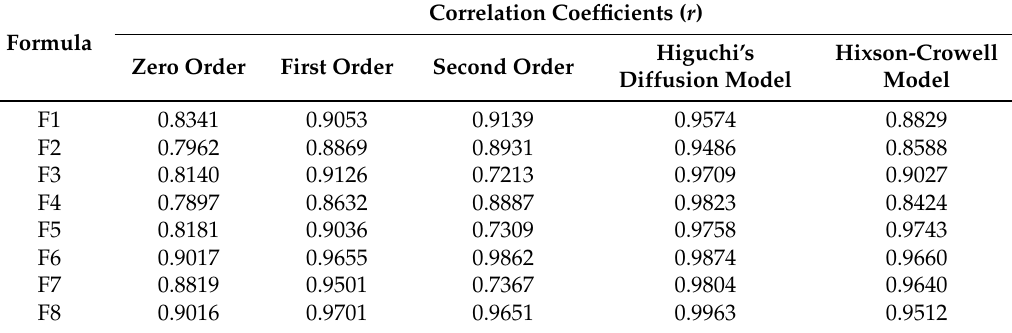
Table 8. The Calculated Correlation Coefficients for the In Vitro Release of OLM from SNEDDS Formulae Employing Different Kinetic Orders or Systems.